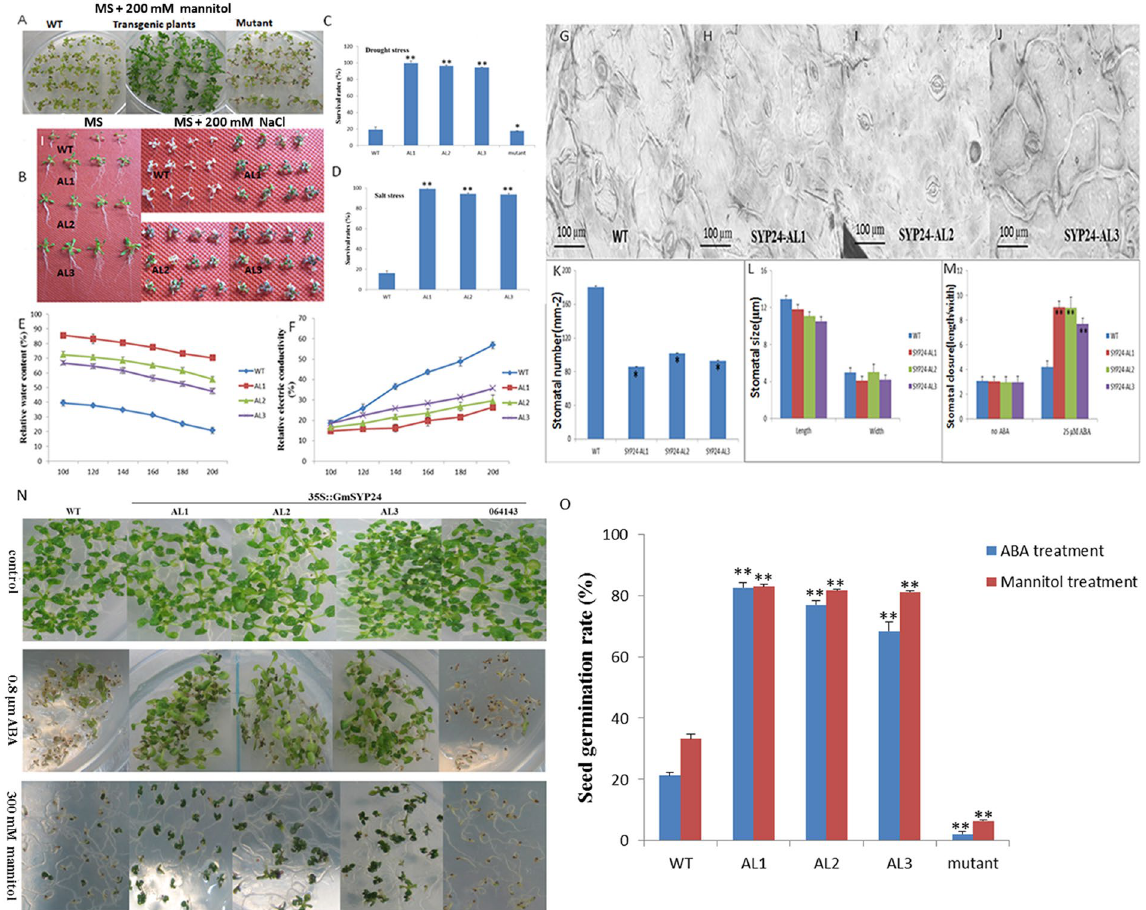
Figure 5. The selection test of drought or salt of transgenic Arabidopsis, wild type and mutant. ( A , B ) The phenotype of transgenic and wild type Arabidopsis with 200 mM mannitol/drought or NaCl. Bar = 10 mm. ( C , D ) The Survival rates and SE values (error bars) were calculated from the results of three biological replicates. Asterisks indicate significantly higher survival rates than the wild type as determined by Student’s t test ( * P < 0. 05; ** P < 0.01). ( E , F ) The relative water content or electric conductivity of wild type and transgenic lines. ( G – M ) The stomatal movement, number, size, and stomatal closure of wild type or GmSYP24hx transgenic plants. ( N ) The germination of GmSYP24 hx, wild type Arabidopsis, and mutant seeds under ABA or mannitol treatment. ( O ) The seed germination rates and SE values (error bars) were calculated from the results of three biological replicates. Asterisks indicate significantly higher survival rates than the wild type as determined by Student’s t test ( * P < 0. 05; ** P < 0.01).